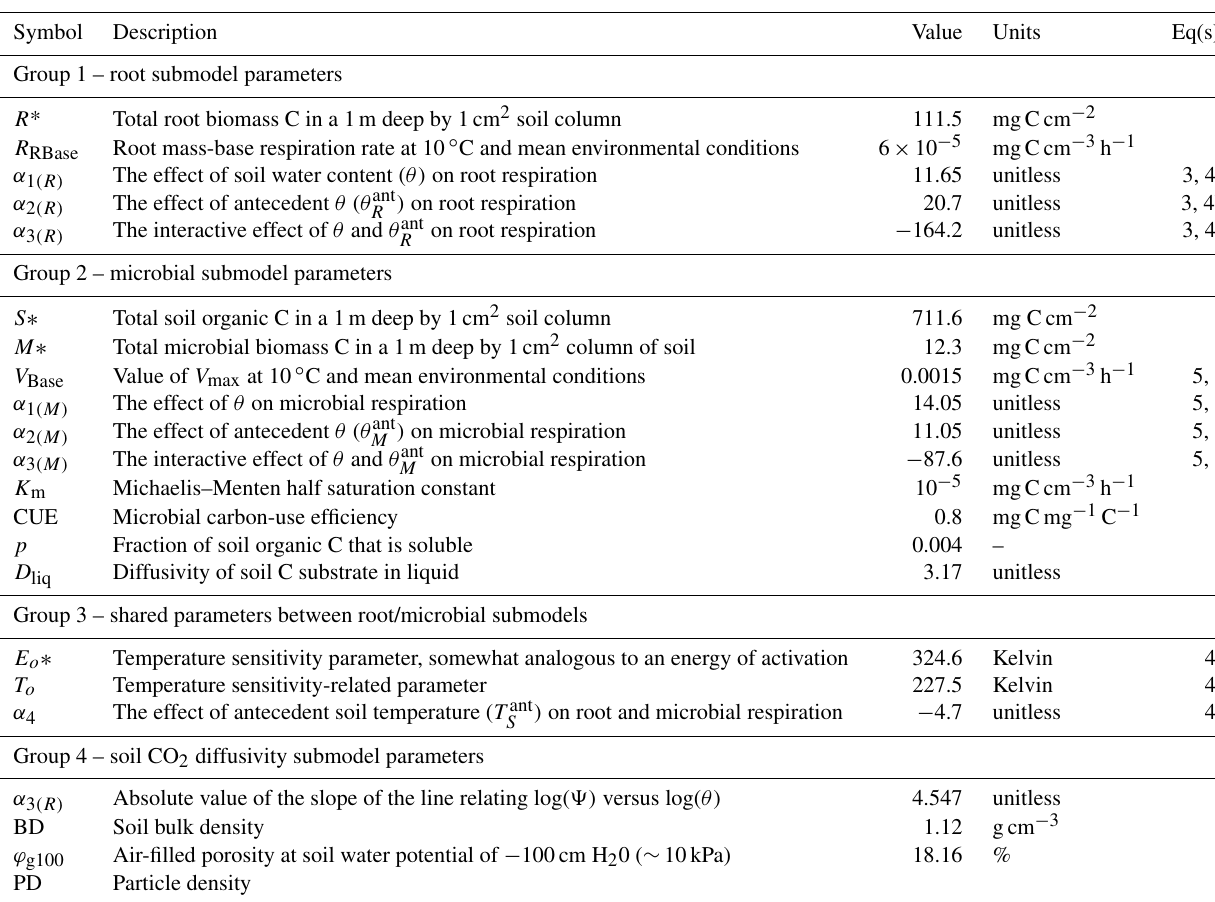
Table 1. Summary of scalar parameters used in the non-steady-state (DETECT) model, arranged into four groups: parameters unique to the microbial respiration submodel for S M (z,t) (group 1); parameters unique to the root respiration submodel for S R (z,t) (group 2); parameters that are shared between the S M (z,t) and S R (z,t) submodels (group 3); parameters used to calculate soil CO 2 diffusivity, D gs (group 4). See Sect. 2.4.5 for details about how the parameters were estimated. Symbol Description Value Units